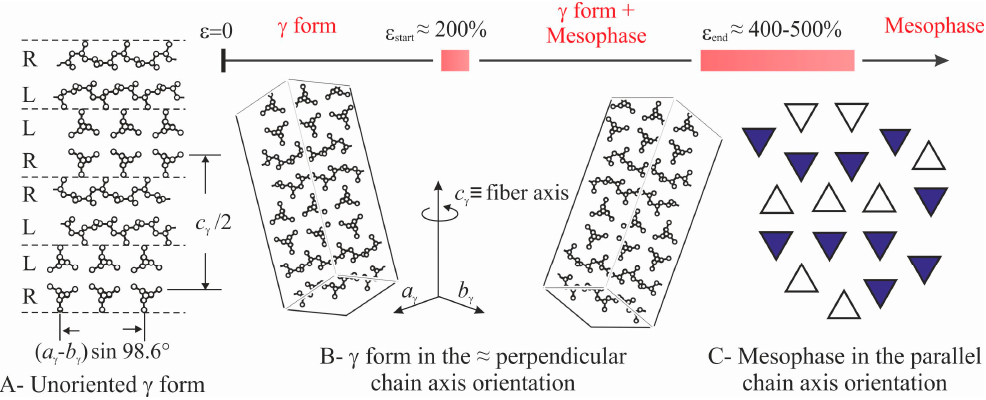
Figure 4. Structural model of γ form ( A ), scheme of the perpendicular chain axis orientation of γ crystals ( B ) and of mesomorphic domains of iPP ( C ), as they develop by effect of stretching, starting from unoriented specimens.